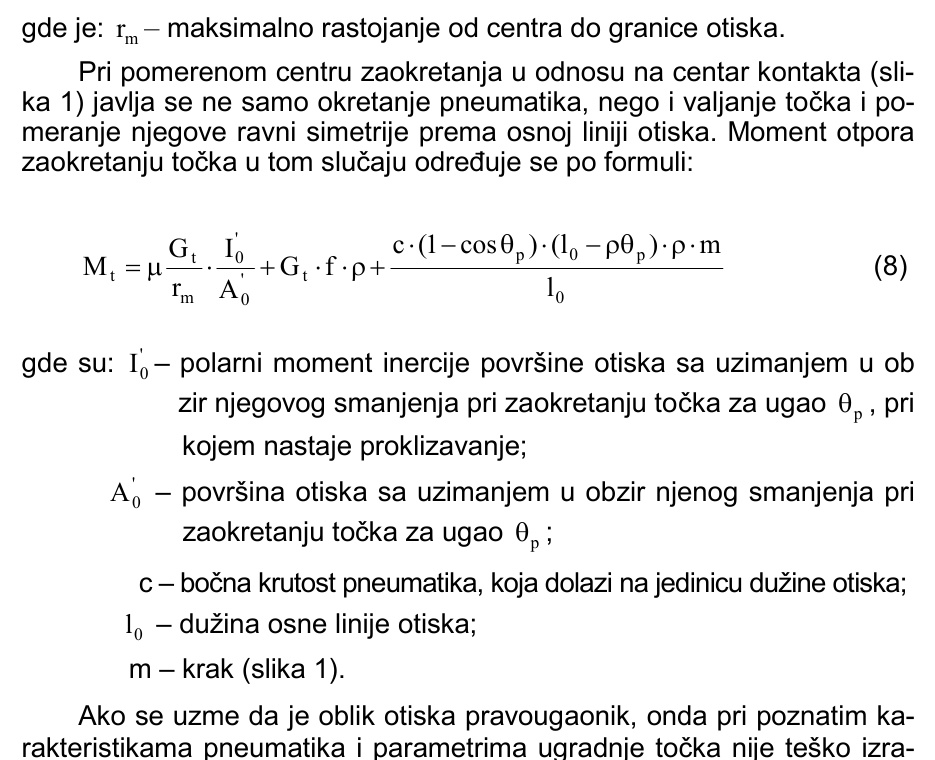
više raste vrednost